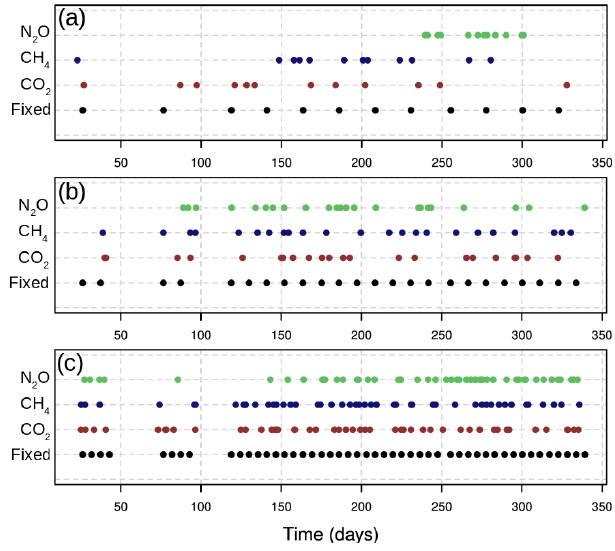
Figure 1. Temporal distribution of fixed temporal stratification (i.e., stratified manual sampling approach) and optimized sampling us- ing a temporal univariate Latin hypercube (tuLHs) approach for k = 12 (a) , k = 24 (b) , and k = 48 (c) . Fixed temporal stratification is in black, soil CO 2 fluxes in red, soil CH 4 fluxes in blue, and soil N 2 O fluxes in green. Time ( x axis) represents days from 1 January to 31 December